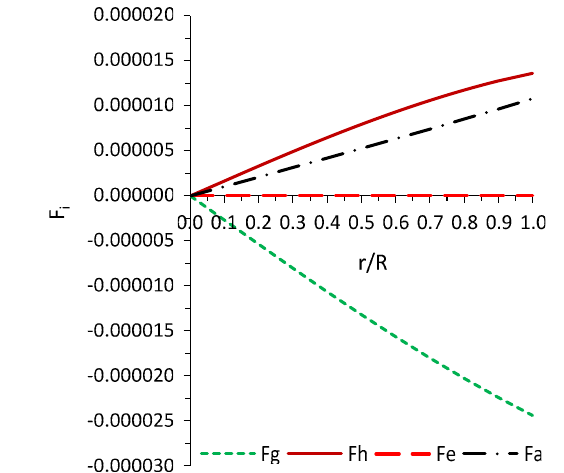
Fig. 8 Feature of the static equilibrium under different forces for RX J 1856-37. For plotting this figure we have employed the same data set of numerical values as used in Figs. 1, 2, 3, 4, 5, 6 and 7